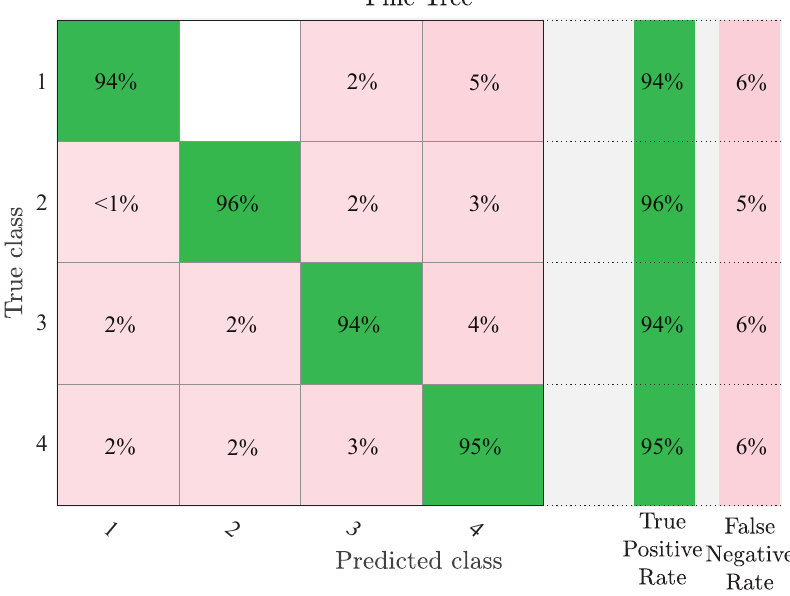
Figure 15. Confusion matrix of decision